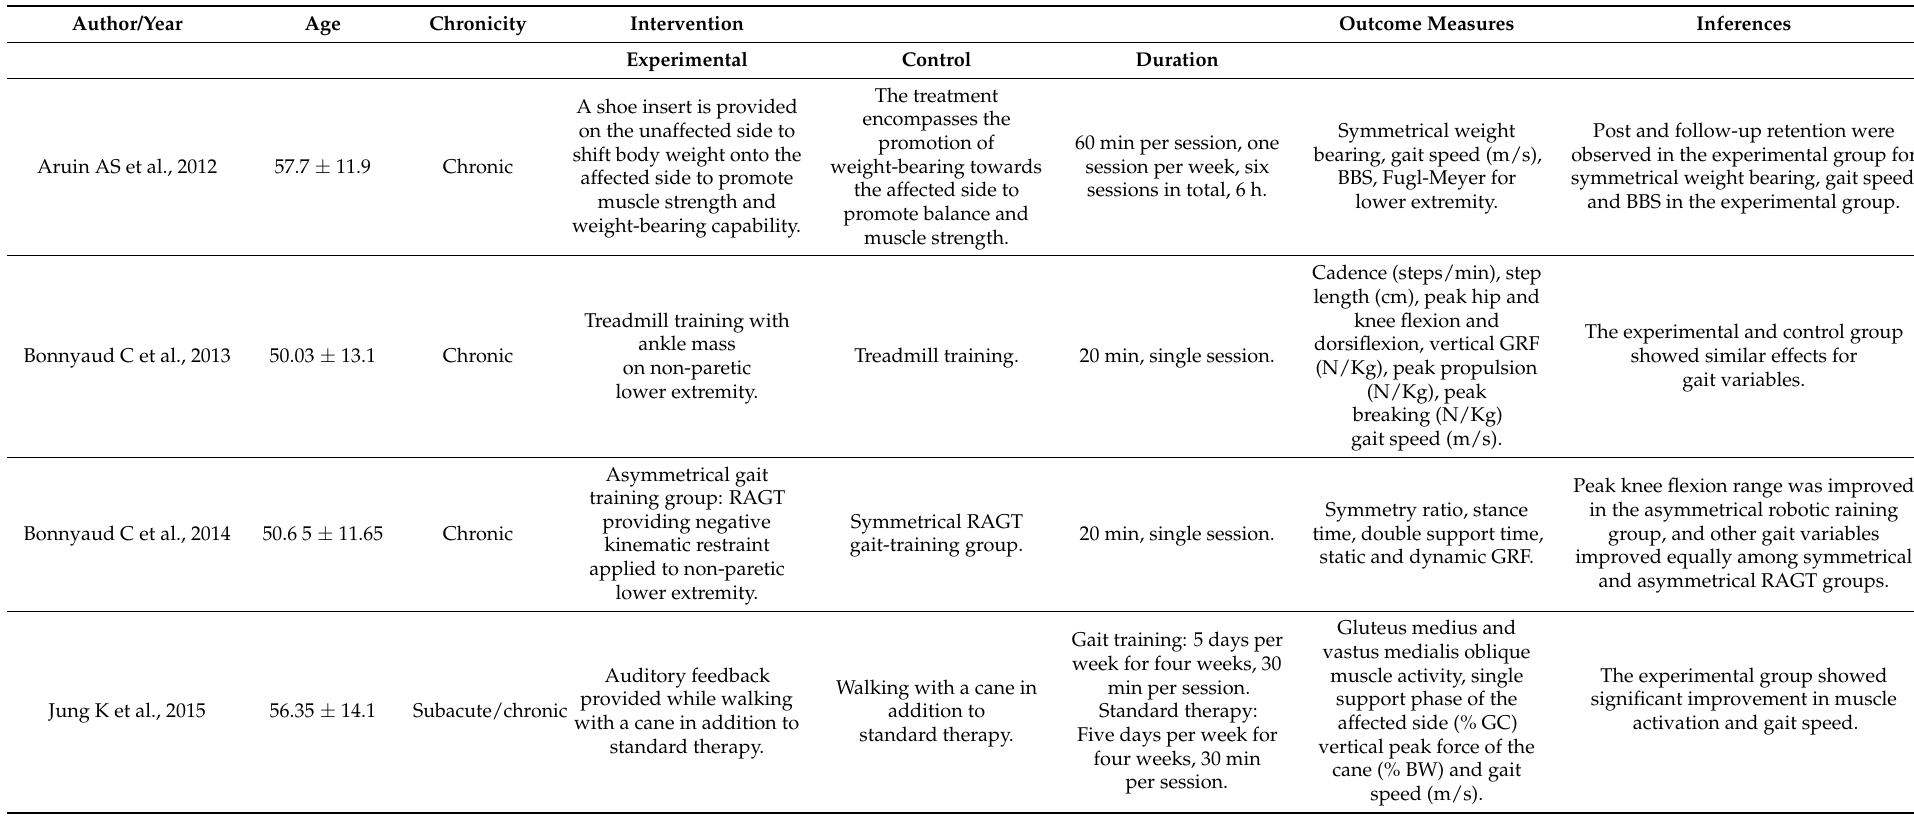
Table 2. Characteristics of studies on lower-extremity constraint-induced movement therapy